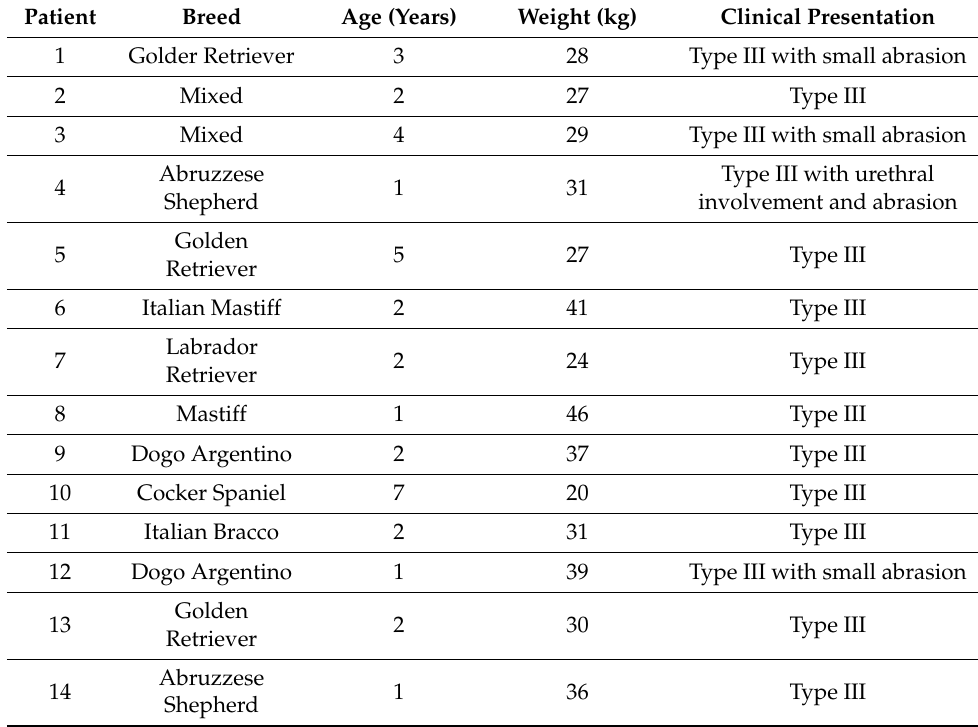
Table 1. Signalment and history of animal involved in the study.